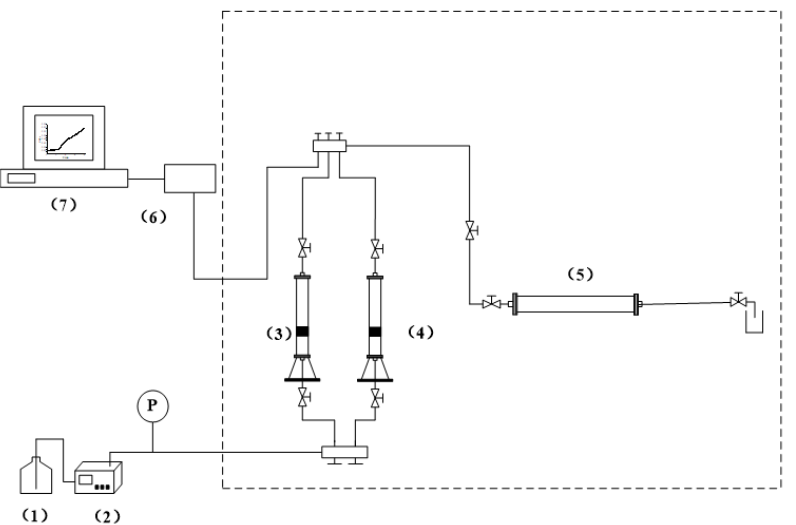
Figure 2. Flow chart of the water plugging experiment. (1) Distilled water tank; (2) horizontal flow pump; (3) brine water tank; (4) plugging agent material tank; (5) sand filling pipe; (6) pressure sen- sor; (7)